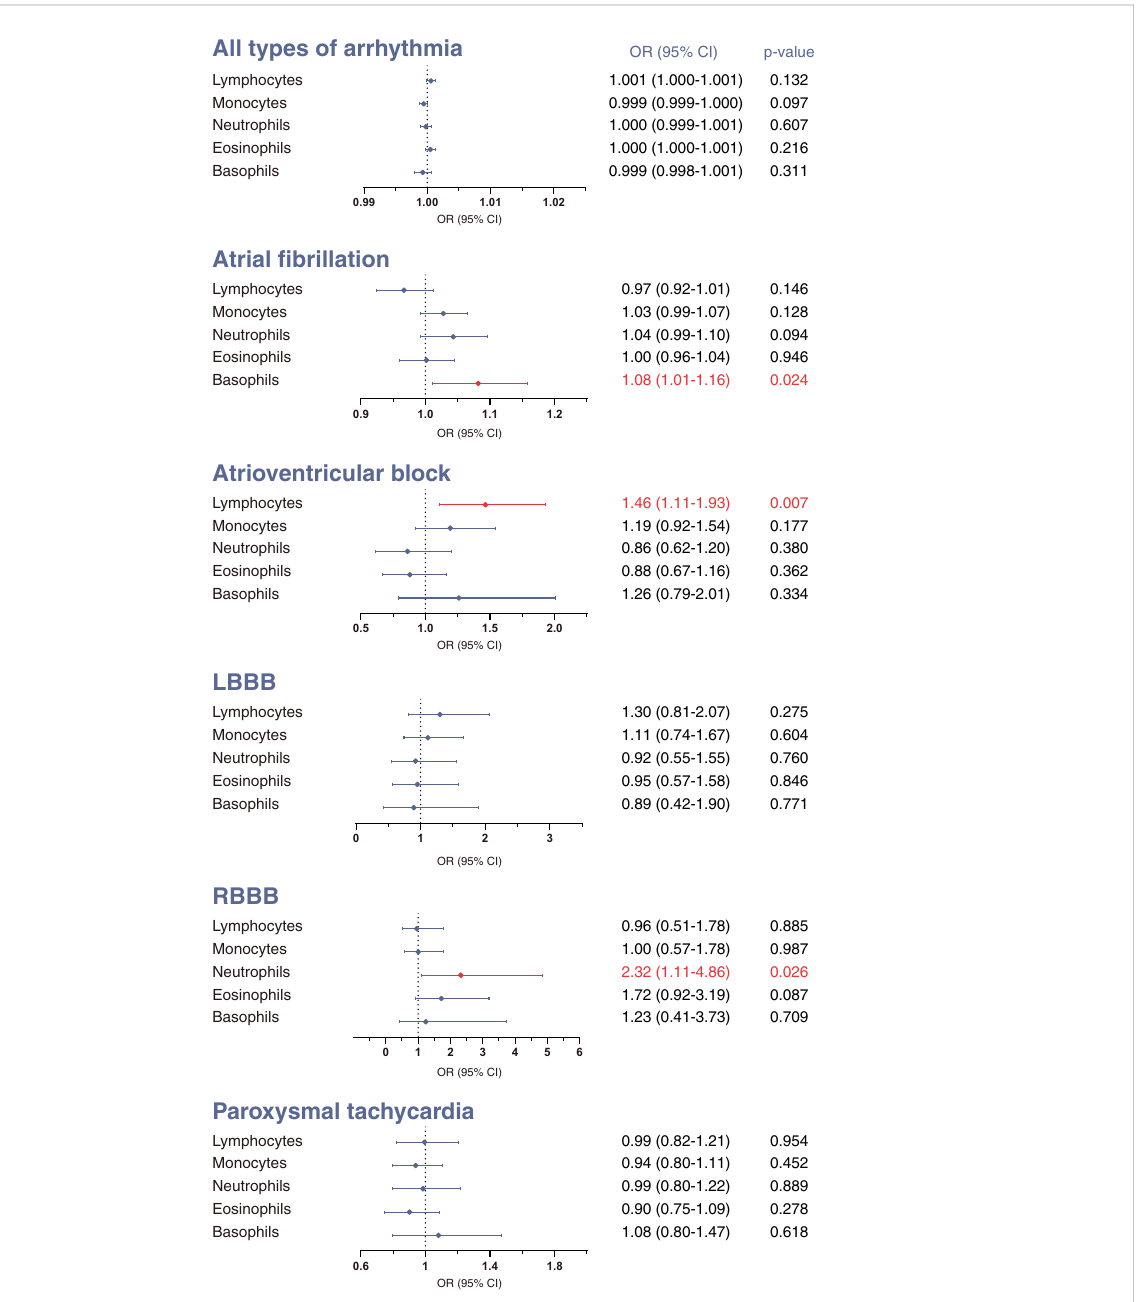
FIGURE 1 Mendelian randomization (MR) estimates derived from the inverse-variance weighted (IVW) method to assess the causal effect of genetically predicted differential leukocyte counts on arrhythmias. Statistical signi fi cance was de fi ned as p<0.05. LBBB, left bundle-branch block; RBBB, right bundle-branch block; OR, odds ratio; CI, con fi dence